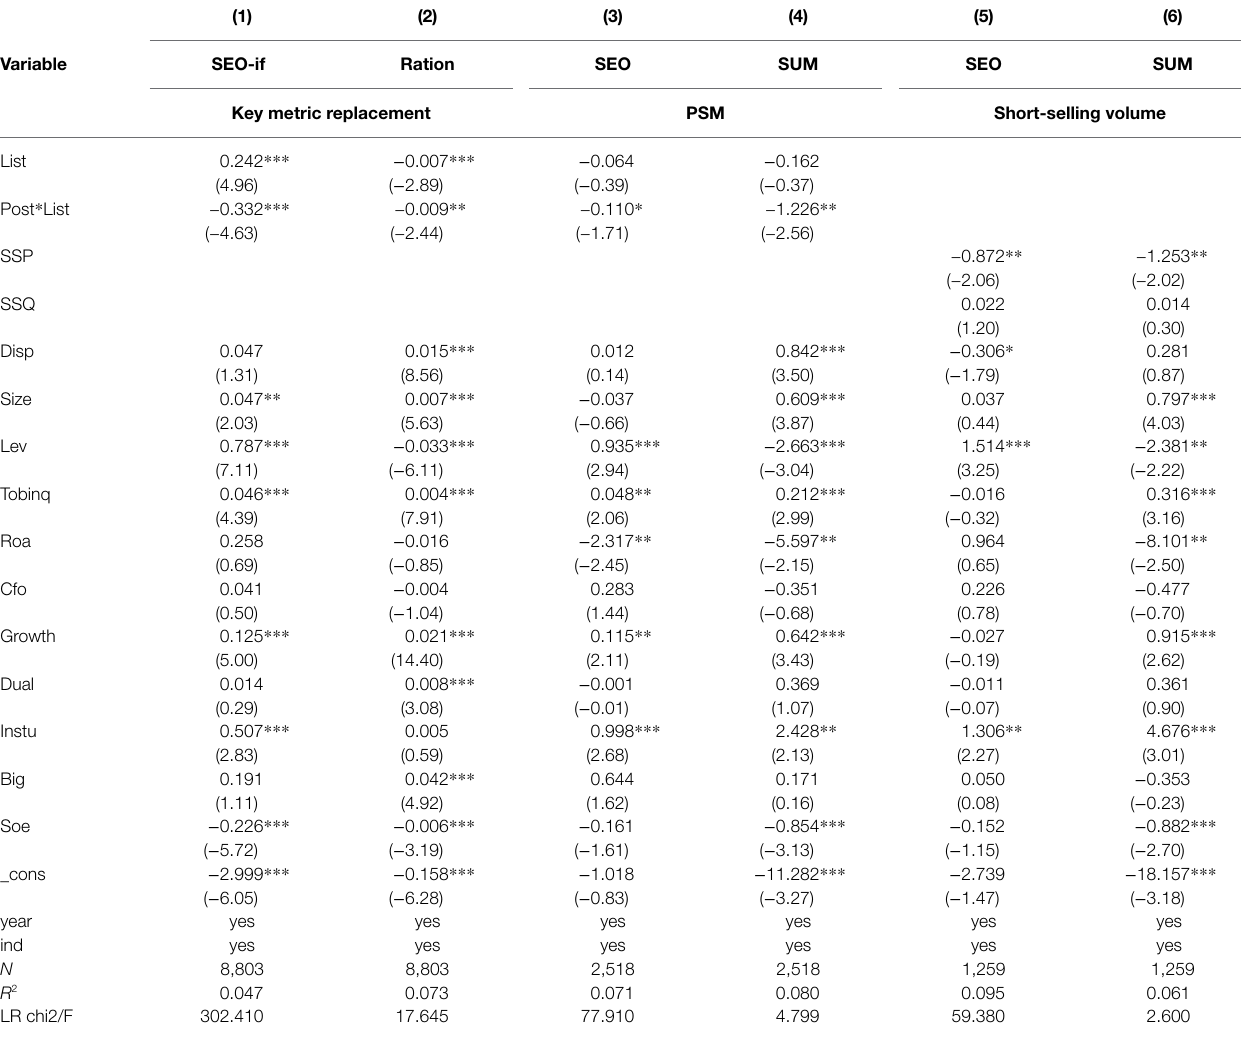
TABLE 5 | The robustness test of relaxing short-selling control and the company’s private equity